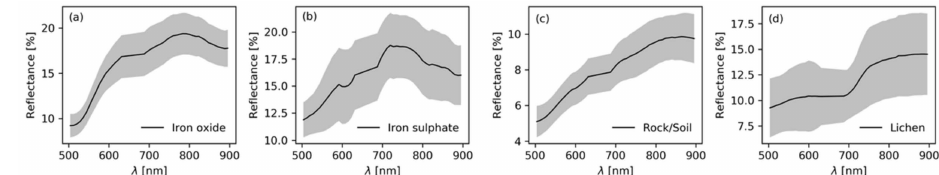
Figure 9. Plots from exemplary spectra that are extracted from the UAS-borne hyperspectral datasets at pixels, where individual spectra are clearly associated with specific surface materials. 20 spectra are grouped per exemplary spectrum with its standard deviation plotted in a grey shaded